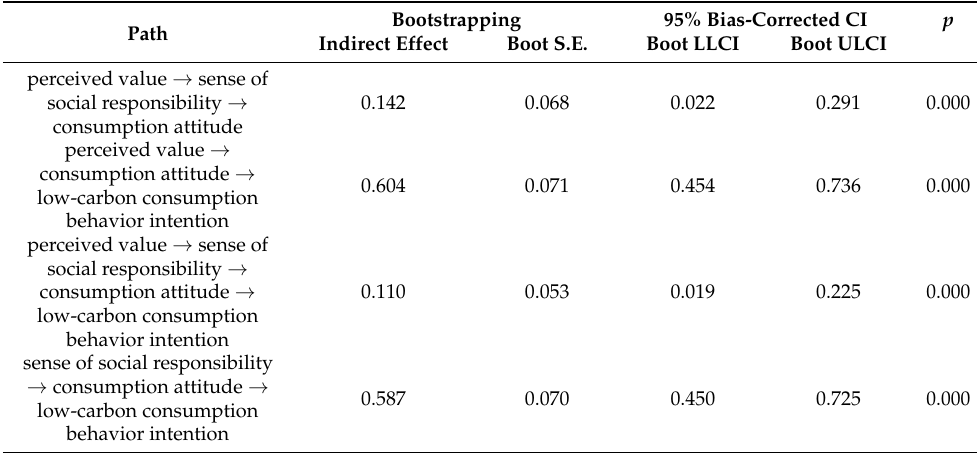
Table 10. Results of mediation analysis using